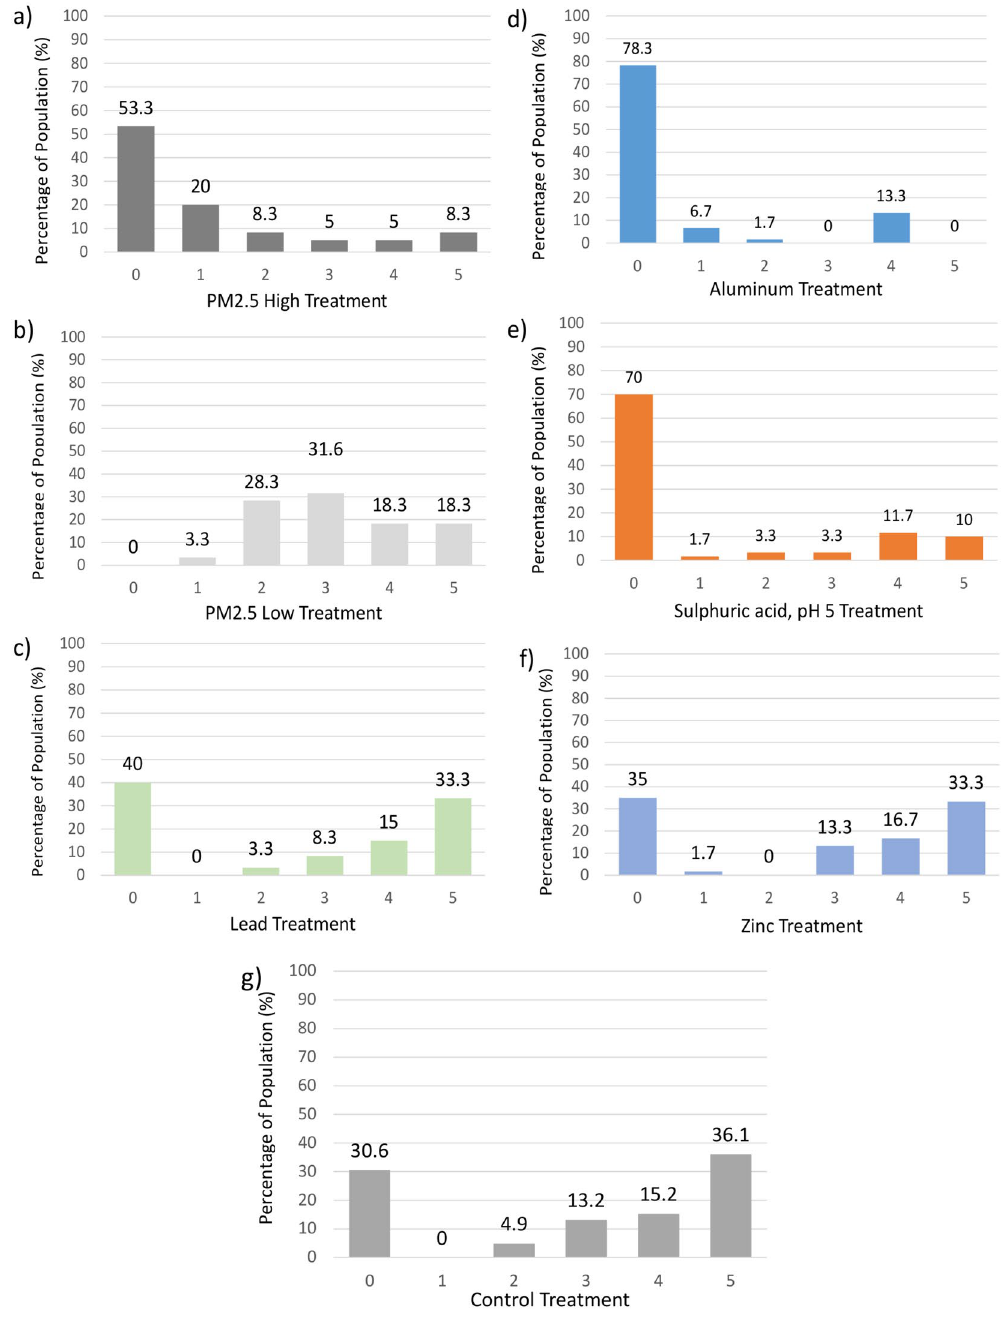
Figure 2. The occurrence distribution (%) of each Behavioral State Score (BSS) from 0 to 5 (x-axis) on each treatment. The y-axis represents the percentage of the sample size that scored a specific category (0–5). For every treatment the total number of snails (n) is 60. The graphs present the results for: ( a ) PM2.5 High Concentration, ( b ) PM2.5 Low Concentration, ( c ) Lead, ( d ) Aluminum, ( e ) Acidity (pH = 5), ( f ) Zinc, ( g ) Control. All setups were performed identically, including the control (a blank consisting of filtered stream water). Treatments of aluminum, acidity (pH = 5), and high PM2.5 concentration had low % values of BSS scores at